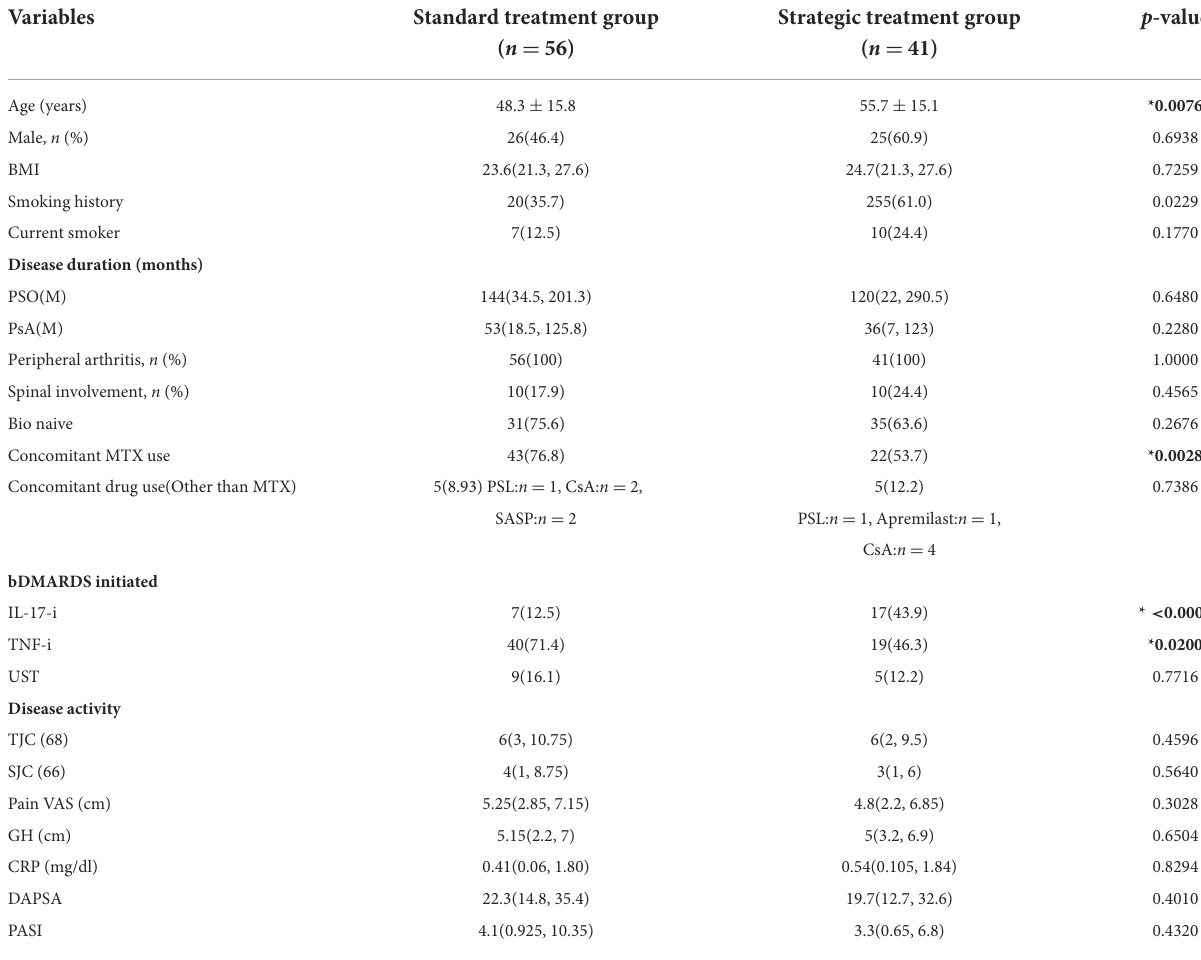
TABLE 1 Differences in baseline characteristics between strategic treatment group and the standard treatment